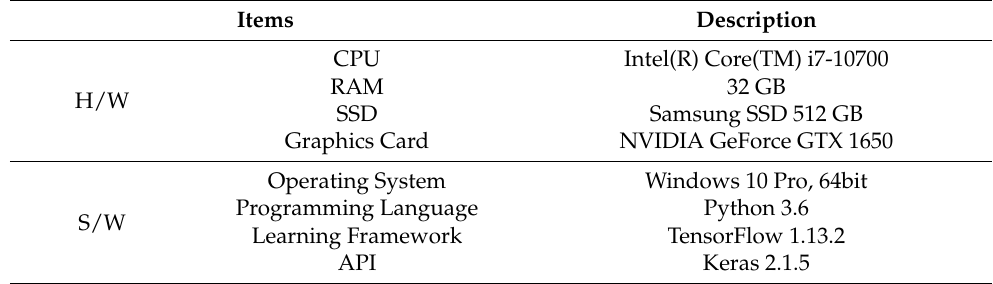
Table 3. The experimental